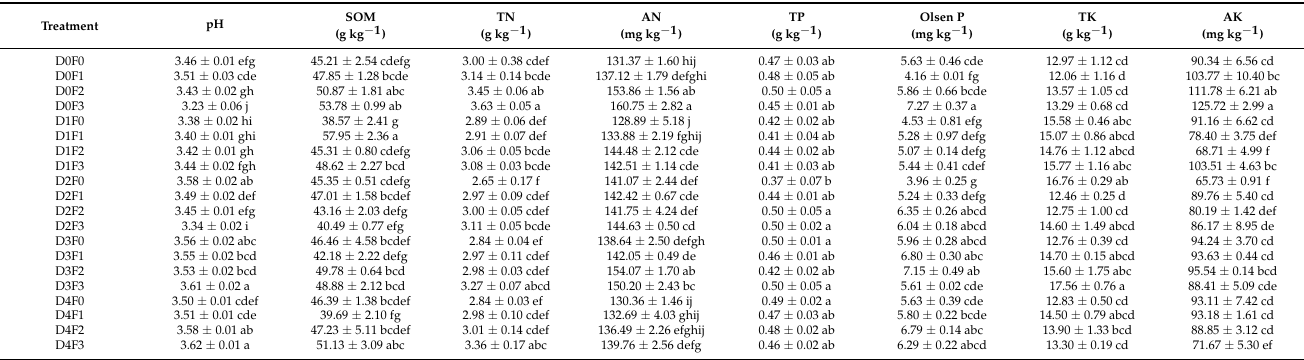
Table A1. Effects of fertilizer and density management on the soil nutrients’ properties in bamboo forests (2018).